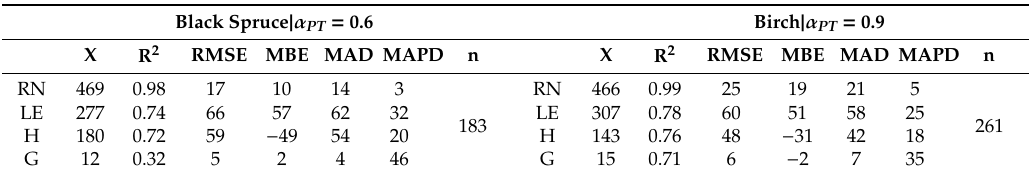
Table 5. Model agreement and error estimation using Terra/Aqua MODIS surface temperature as T RAD and an initial TSEB α PTC value 0.6 and 0.9 for black spruce and birch settings, respectively. Error estimators (RMSE, MBE, MAD) are in W·m −2 while MAPD is in %. X are the mean values for the estimated energy balance components in W·m −2